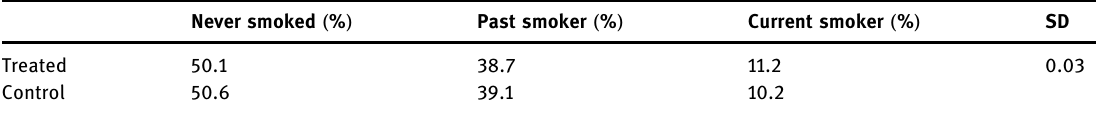
Table A6: Standardized di ff erences ( SD ) between treated and control populations in the RCT gold dataset, for the measured smoking variable